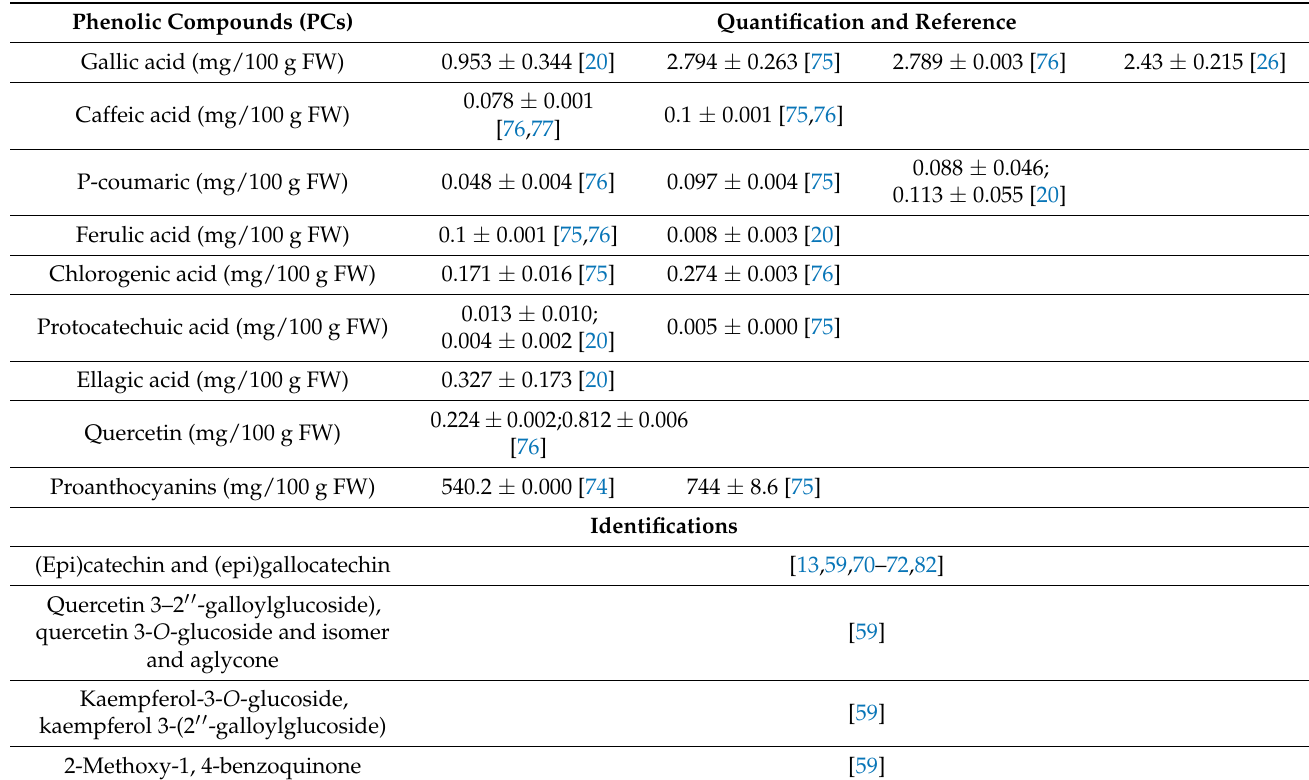
Table 2. Main phenolic compounds from persimmon fruits quantified and